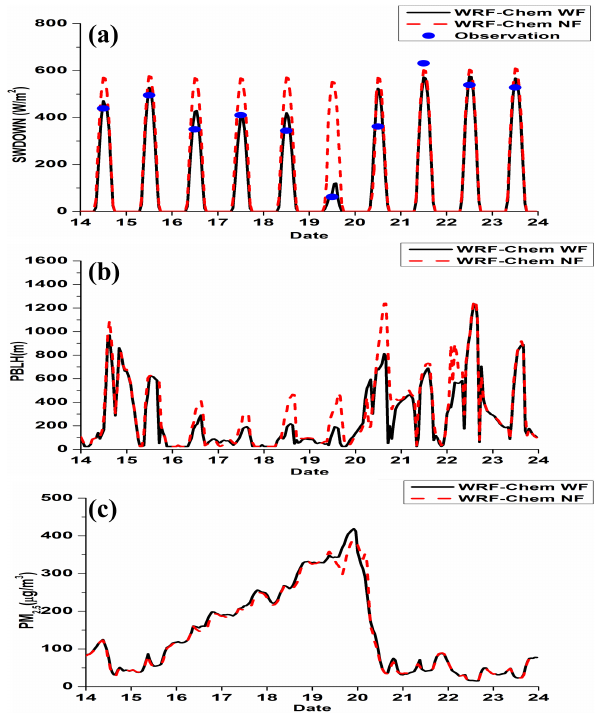
Figure 13. Observed daily maximum surface solar radiation and simulated surface shortwave radiation for the with feedback (WF) and without feedback (NF) scenarios in Beijing (a) , simulated PBLH (b) in WF and NF scenarios at Shijiazhuang, and simulated PM 2 . 5 concentration (c) in WF and NF scenarios at